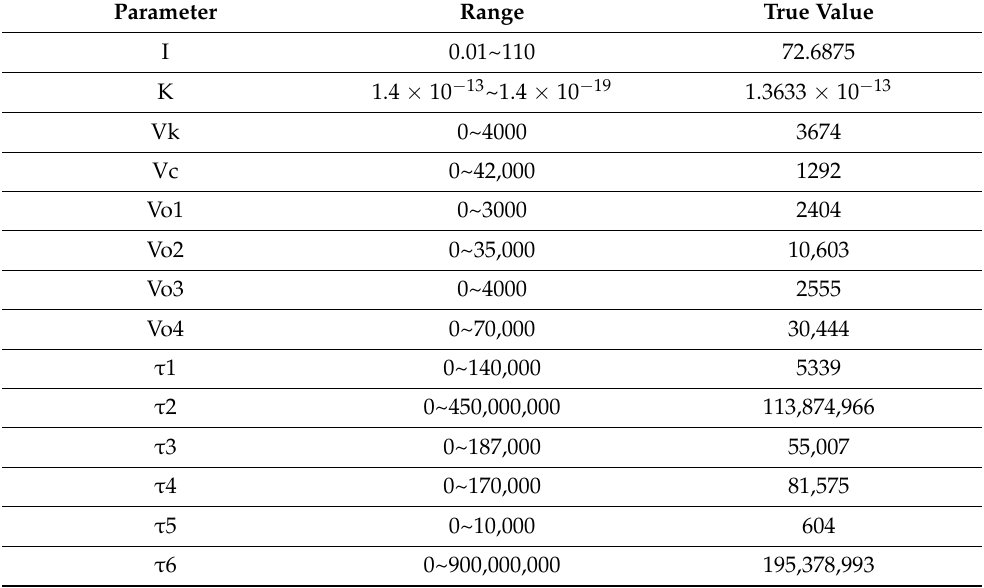
Figure 19. GA results 2 (L brand 18650): reduce the range at the arrow. Table 6. The parameters of GA (L brand 18650).